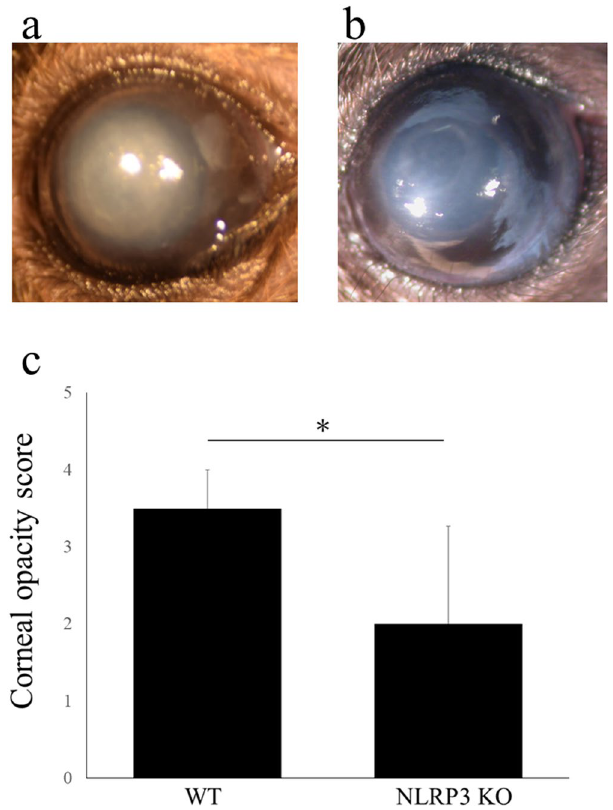
Figure 2. Corneal opacity induced by alkali burn is suppressed in NLRP3 KO mice cornea. Representative photographs are shown. Compared with WT mice (a, opacification grade 4; intense stromal opacity, only outline of pupil is visible), the opacification is suppressed in NLRP3 KO mice (b, opacification grade 2; minimal to moderate opacity including corneal stroma). Using opacification grade, it is shown that corneal opacity in NLRP3 KO mice ( b ) is significantly diminished compared with WT mice ( a ) (N = 10 each, WT mice; 3.5 ± 0.5, NLRP3 KO mice; 2.0 ± 1.2, * P < 0.05, MannWhitney U -test) on day 7 after alkali burn injury ( c